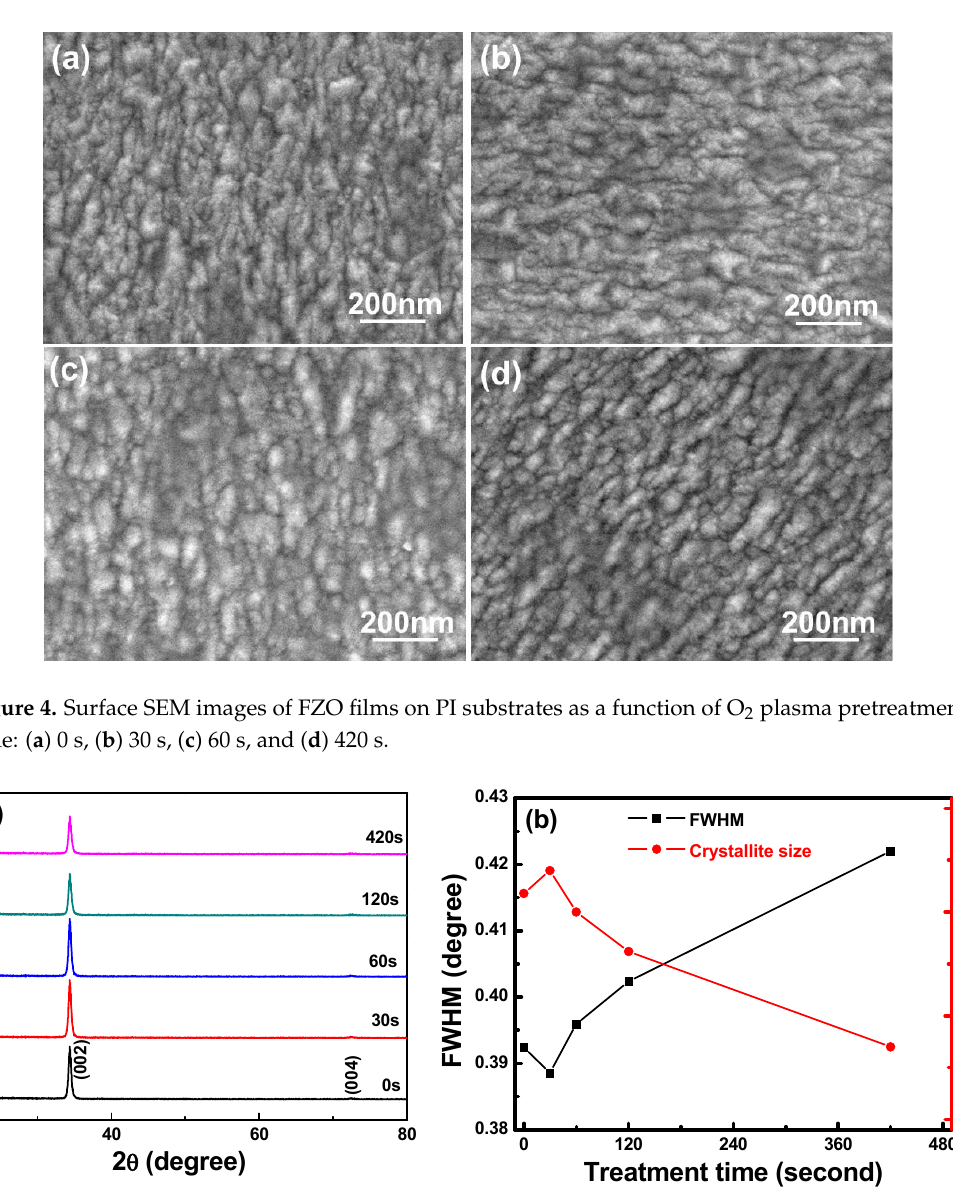
Figure 5. ( a ) XRD patterns and ( b ) full width at half maximum (FWHM) values and crystallite sizes of FZO films on PI substrates as a function of O 2 plasma pretreatment time.